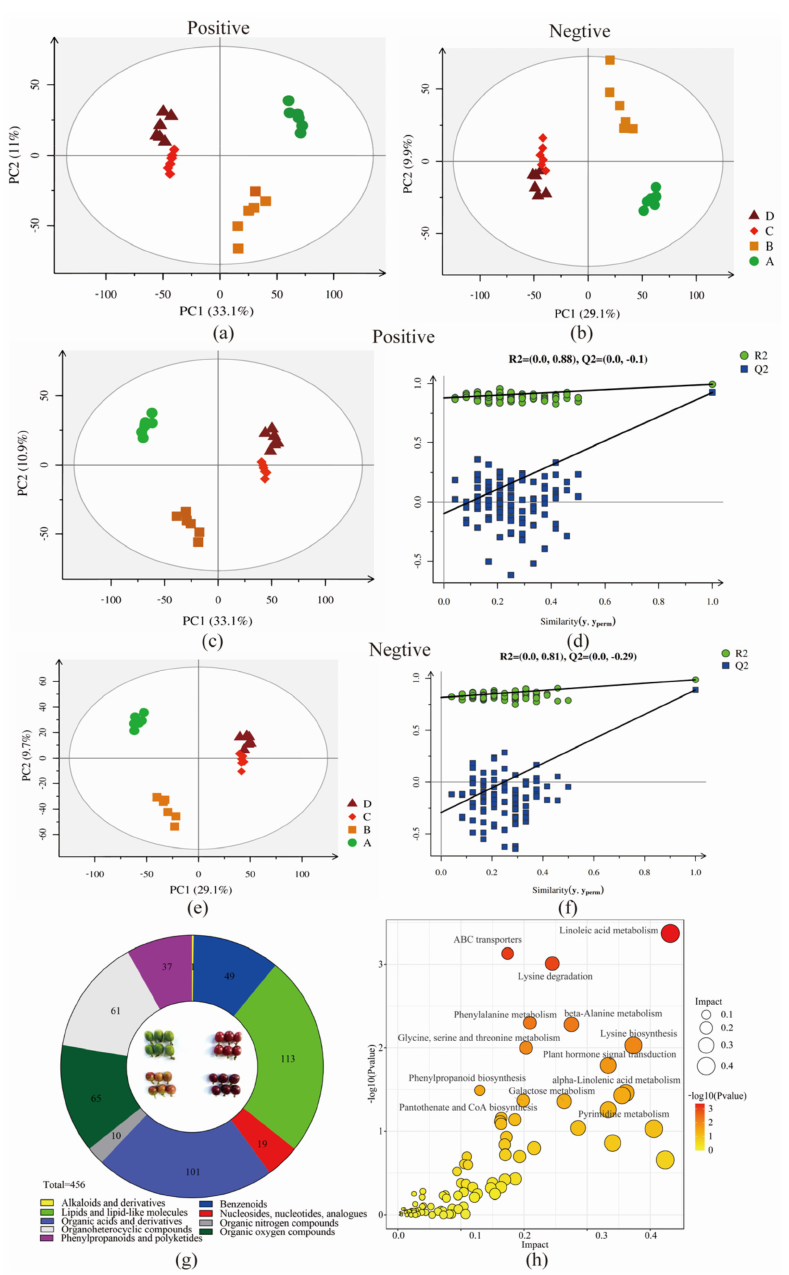
Figure 2. Principal component analysis (PCA) of peak areas detected in four groups of coffee samples in positive and negative ion models ( a , b ) (four maturity stages: A ( • ), B ( (cid:4) ), C ( (cid:7) ), D ( (cid:78) )). Partial least squares discriminant analysis (PLS-DA) and permutation test of peak areas in positive and negative ion models in four group samples ( c – f ). Classification of DEMs in four group samples ( g ). KEGG pathways of DEMs involved ( h